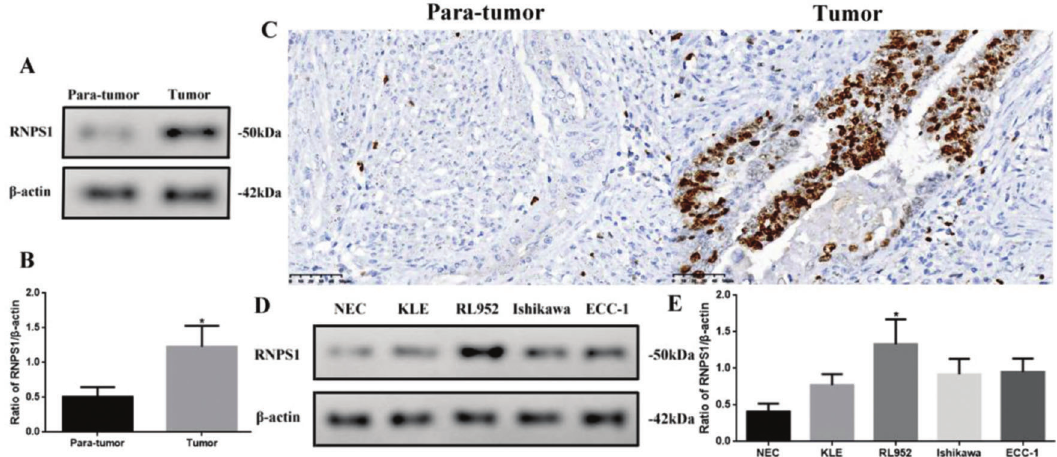
Figure 2 - (A) RNPS1 expression, (B) quantitation of the RNPS1 expression levels from the western blots, and (C) IHC staining analysis for RNPS1 in para-tumor and tumor tissues ( (cid:2) 400). (D) RNPS1 expression in NEC, KLE, RL952, Ishikawa, and ECC-1 cells. (E) Quantitation of the RNPS1 expression levels in cells. Protein levels were normalized to those of b -actin. (n=6, * p o 0.05: tumor vs. para-tumor or RL952 vs. other cells).